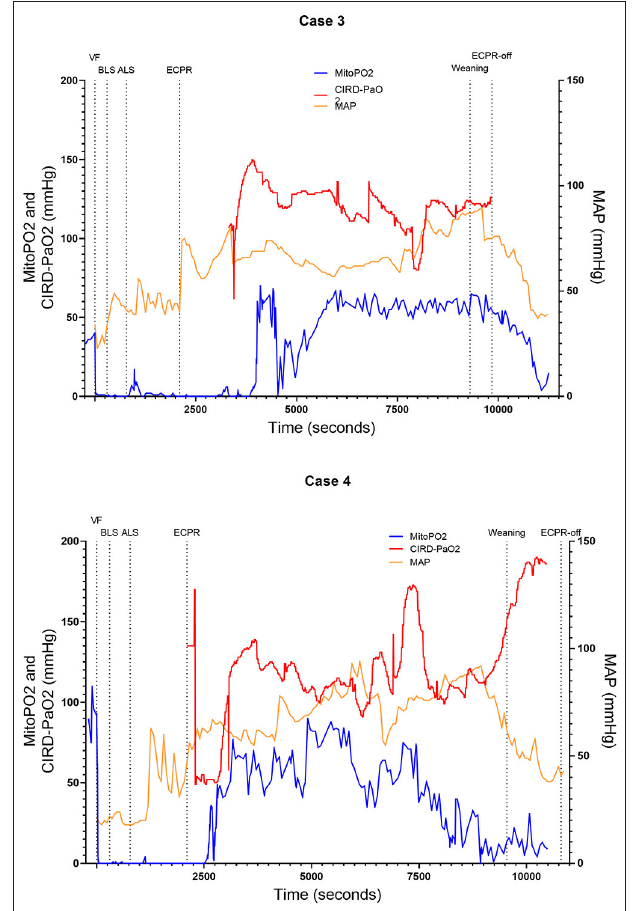
FIGURE 3 | Course of mitoPO 2 , CIRD-PaO 2 , and MAP for experimental tests case 3 and 4. Course of mitoPO 2 and CIRD-PaO 2 in mmHg levels at the left Y -axis and course of MAP in mmHg levels at the right Y -axis all over time in seconds. Case 3 at the above panel and case 4 at the below panel. VF, ventricular fibrillation; ECPR, extracorporeal cardiopulmonary resuscitation; CIRD-PaO 2 , arterial partial oxygen pressure measured by controlled integrated resuscitation device; mitoPO 2 , mitochondrial partial oxygen